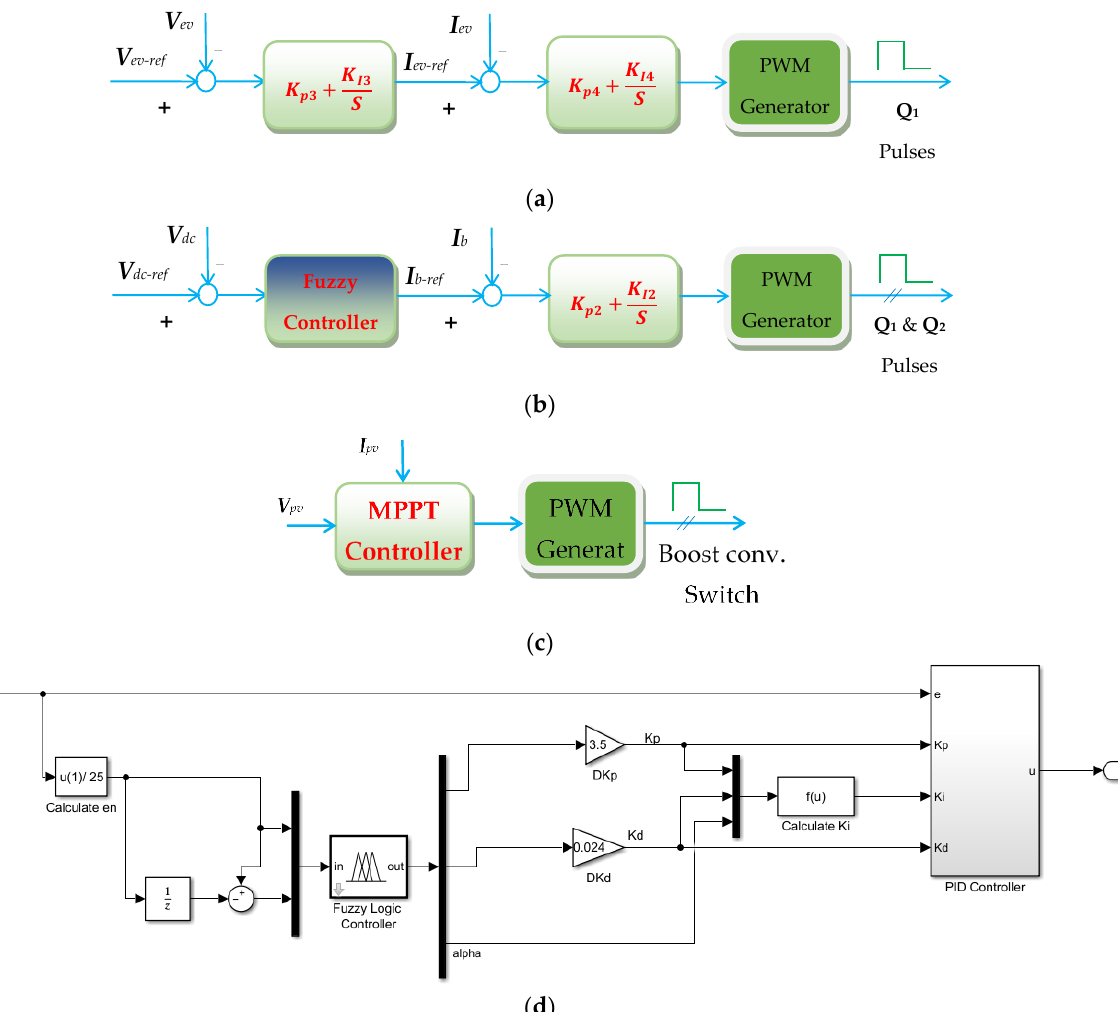
Figure 4. The block diagram of the system controllers: ( a ) EV converter controller, ( b ) ESS charge controller, ( c ) MPPT controller, and ( d ) fuzzy PID controller.